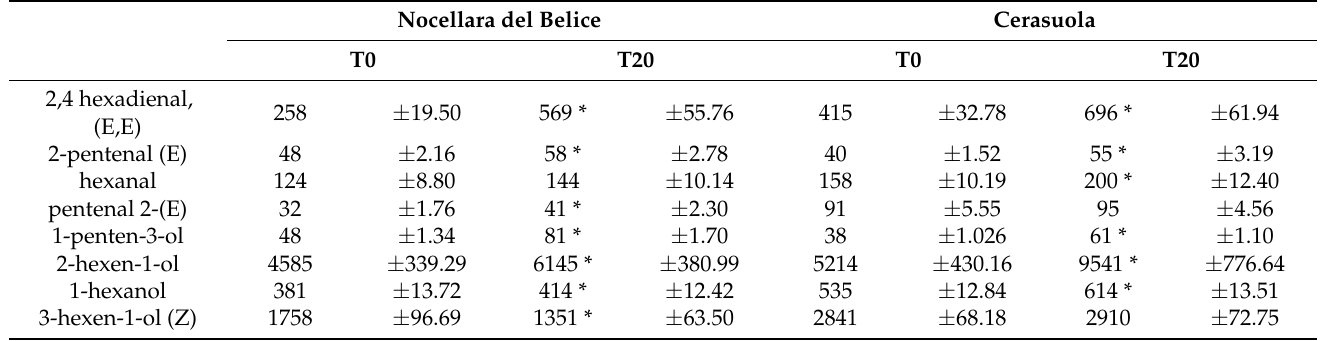
Table 10. Volatile composition (mean ± SD) of Nocellara del Belice and Cerasuola EVOOs for tests T0 (unmodified malaxation) and T20 (modified malaxation, with the application of the SCADA platform). Data are expressed in